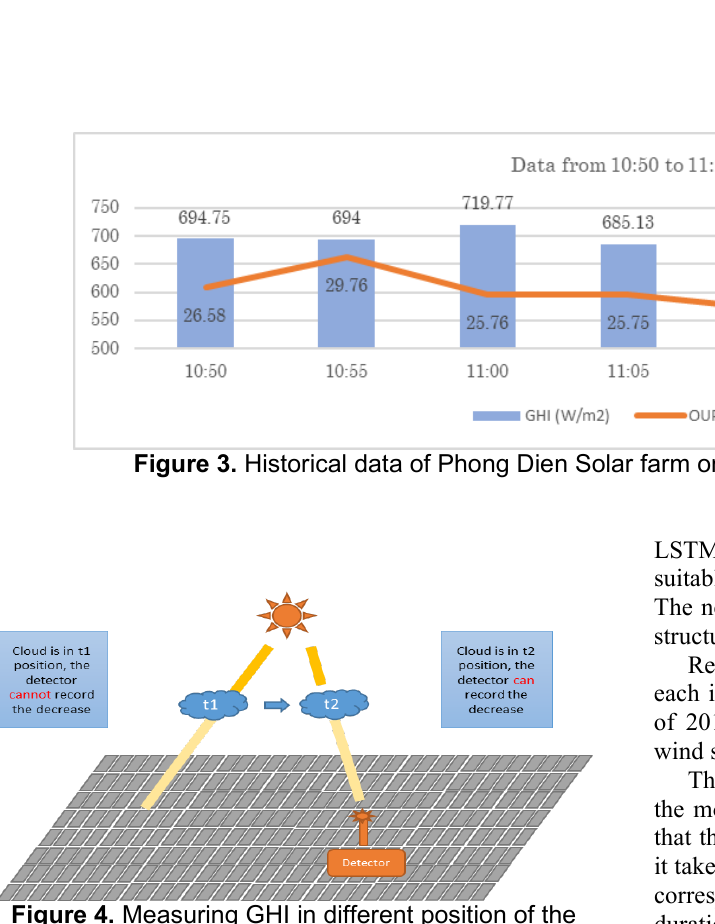
Figure 2. Five minutes historical data of Phong Dien Solar farm on June 30, 2019